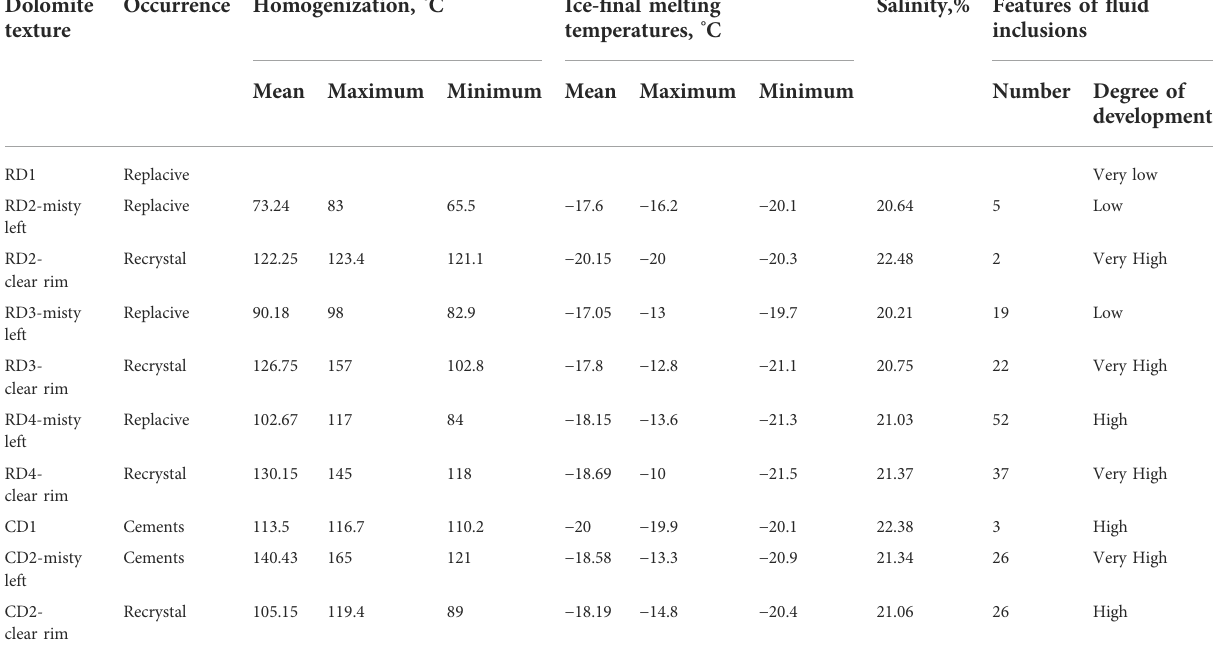
TABLE 2 Homogenization and ice- fi nal melting temperatures of fl uid inclusions in different dolomites. Dolomite Occurrence Homogenization, ° texture